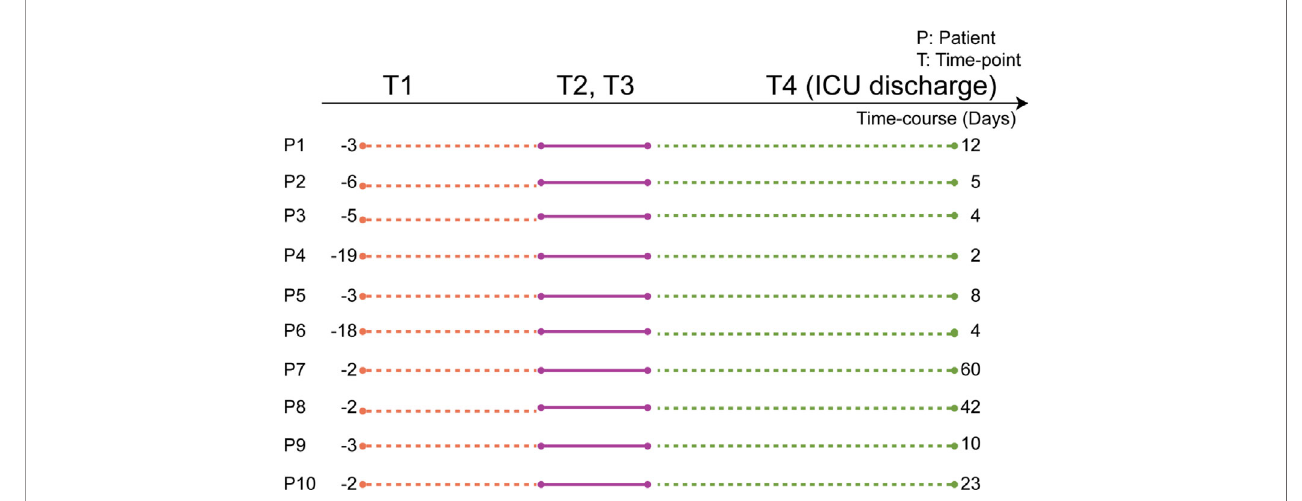
FIGURE 1 | Scheme of the timing of the plasma sample collection, based on each patient ’ s physiological state. Plasma samples were collected from ten individuals each at four subsequent time-points. T1 is when each patient underwent elective surgery. The time-points T2 and T3 represent plasma collections at two consecutive days at the start of the assumed septic episode. T4 was collected when patients were discharged from the ICU. The numbers represent the elapsed number of days between the time points for each patient. Full patient descriptors including age and sex are provided in Supplementary Table 2